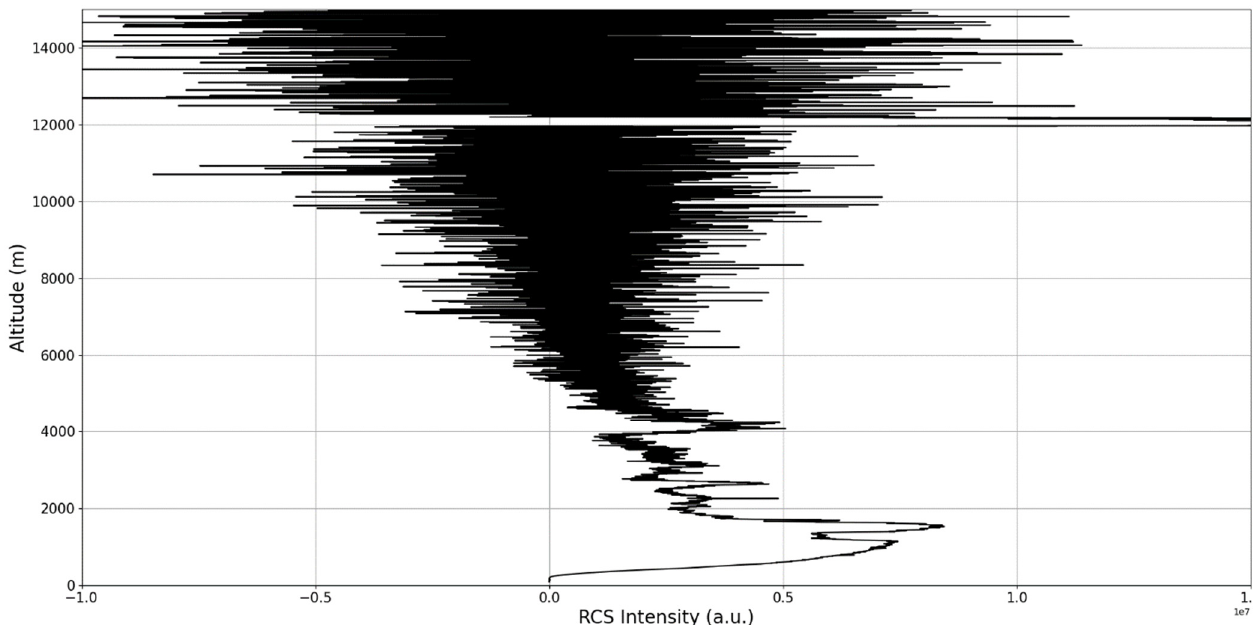
Figure 6. RCS profile corresponding to point B.